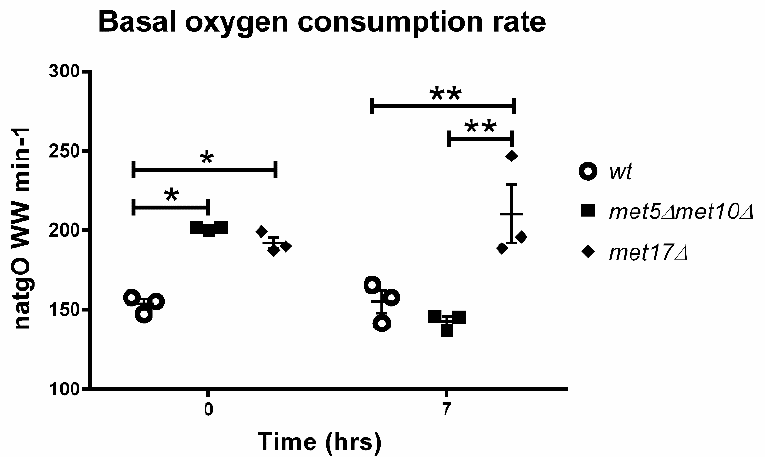
Figure 6. Yeast mutants that accumulate H 2 S synthesize ethanol faster and more ATP than lower endogenously accumulated H 2 S. ( A ) The 48 h precultures of yeast cells of the strains wt , met5 ∆ met10 ∆ , and met17 ∆ were resuspended in fresh media, and supernatants were collected every hour. Ethanol production was measured in vitro at 37 °C. ( B ) Yeast cell cultures at exponential and stationary phases of the strains wt , met5 ∆ met10 ∆ , and met17 ∆ were lysated, and ATP was quantified. ATP production was measured in vitro at 37°C. One-way ANOVA * p < 0.05, ** p < 0.01. Open circles, wt ; closed squares, met5 ∆ met10 ∆ ; closed diamonds, met17 ∆ .